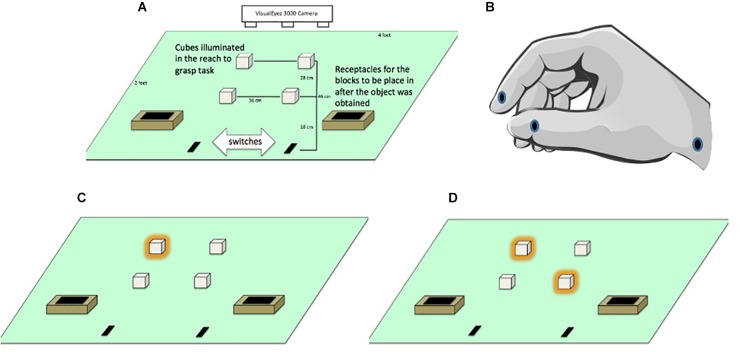
(A) General layout of apparatus monitored by a VisualEyez 3000 Camera. Participants reached forward to grasp and relocate translucent cubes (2 cm × 2 cm × 2 cm) lit by LEDs into “treasure chests” as quickly and as accurately as possible. (B) Position of the LEDs located on the index finger, thumb and wrist. (C) Illuminated targets in the unimanual left far condition. (D) Illuminated targets in the bimanual asymmetric left far/right near condition.